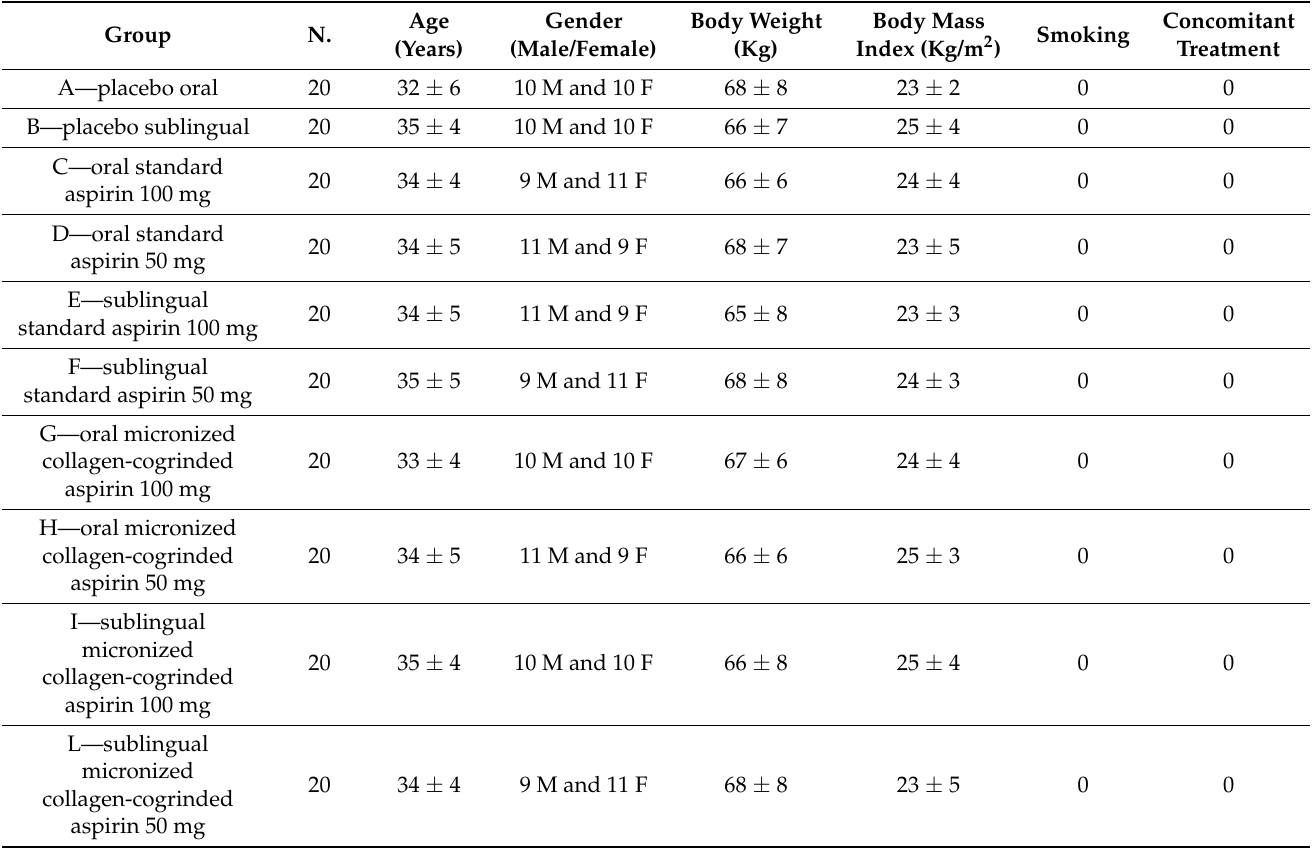
Table 1. Demographics of healthy volunteers enrolled in the study. Values are expressed as mean ±